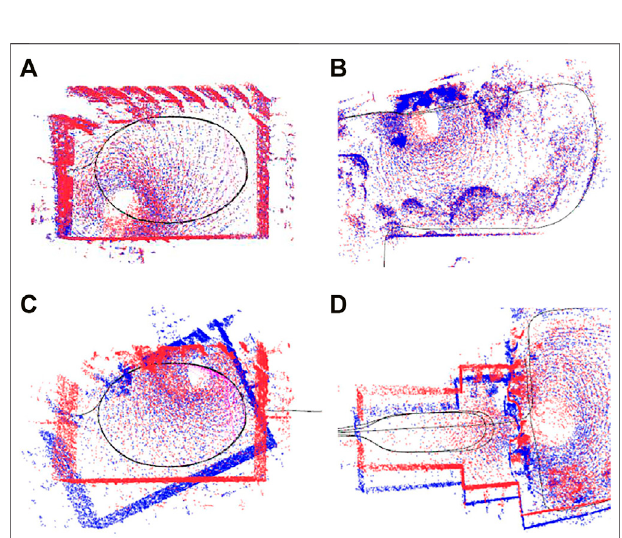
FIGURE 8 | Examples of loop closure constraints created by our (intentionallyrelaxed) LiDAR-SLAM system. (A,B) : True-positive loop closures show the red and blue point clouds are properly aligned. (C,D) : False-positive loop closures which do not properly align the red and blue point clouds but are plausible as many points have very low registration error.